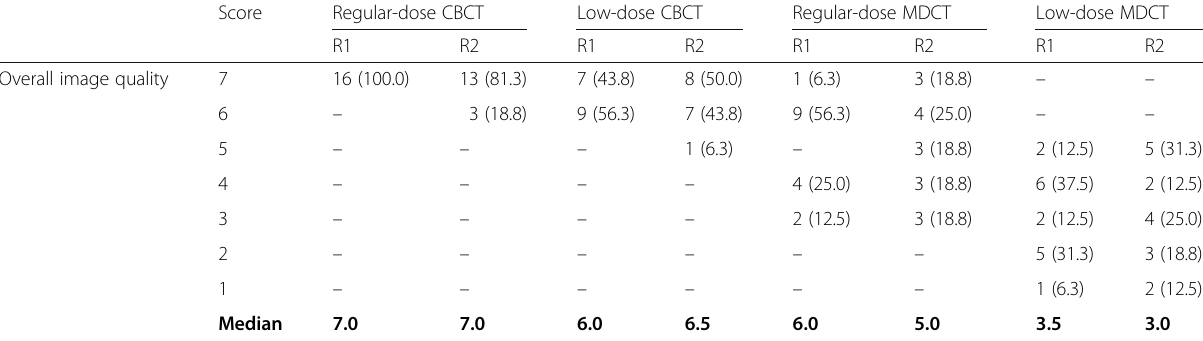
Table 2 Subjective evaluation of cone-beam (CBCT) and multidetector CT (MDCT) image quality by two radiologists (R1, R2) using a seven-point Likert scale Score Regular-dose CBCT Low-dose CBCT Regular-dose MDCT Overall image